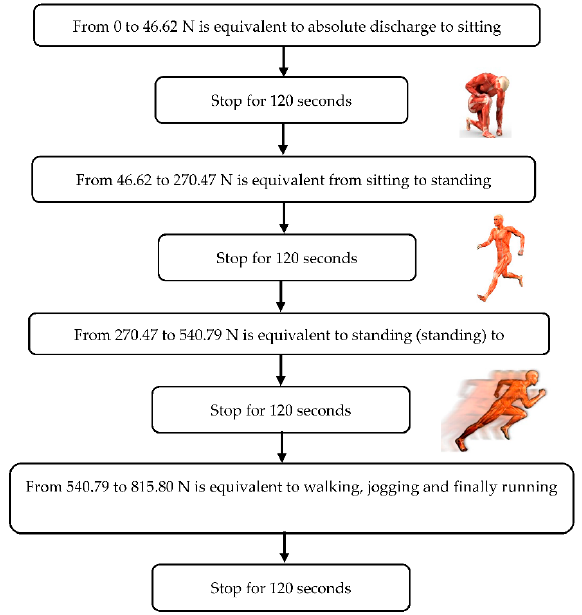
Figure 2. Work algorithm in statics.